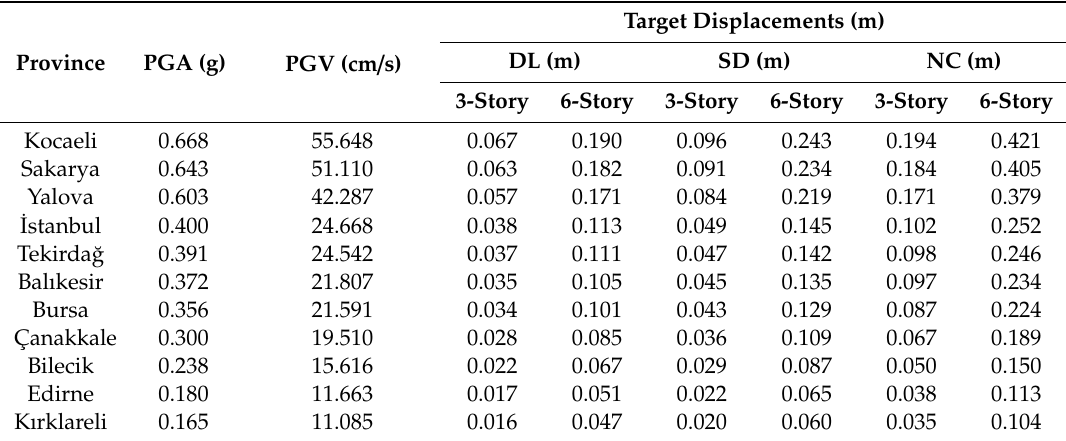
Table 10. Comparisons of earthquake—structural parameters.